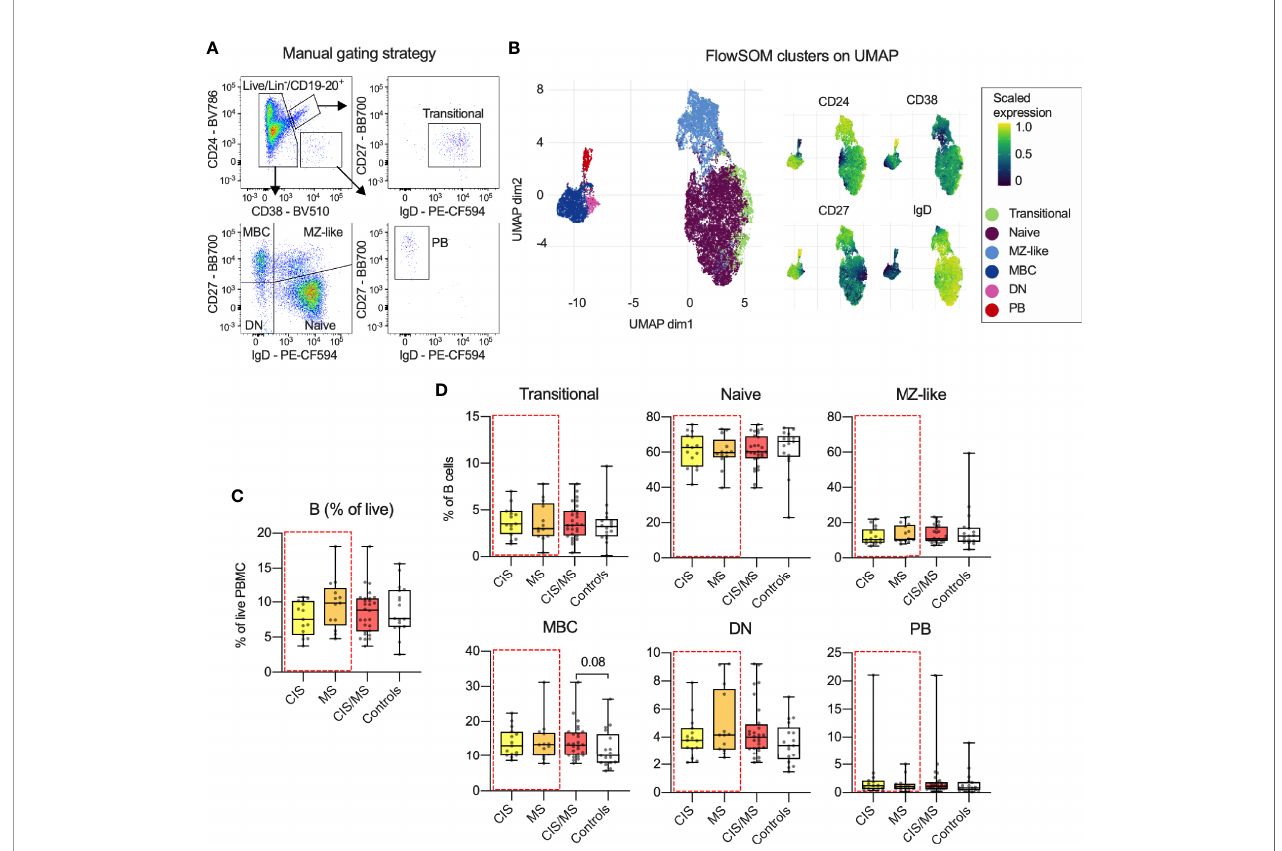
FIGURE 1 | (A) Gating strategy and B cell subset de fi nitions. (B) Clusters identi fi ed using FlowSOM clustering and UMAP-based visualization on the total B cell population as well as expression of relevant markers across each cluster. (C, D) Abundance of total B cells (C) and proportion of B cell subsets (D) within the B cell population in CIS, MS, combined CIS/MS and compared to controls. Data in (A) are representative from one individual and in (B) a representative subset of 33 study participants. Data in (C, D) are displayed for each participant, together with box/whiskers display for median and range (n CIS = 15, n MS = 13, n Controls = 17). Signi fi cance of difference between patient groups versus controls was calculated using Mann-Whitney non-parametric test and displayed as respective p